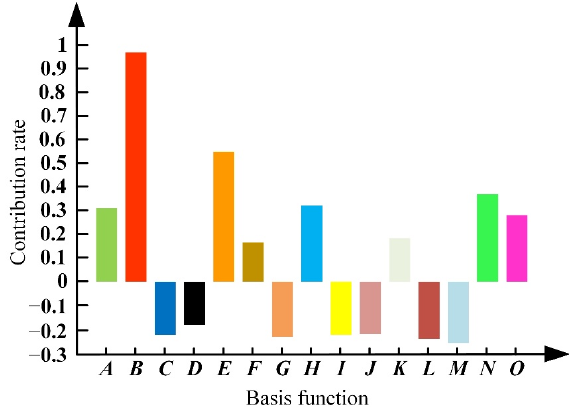
Figure 6. The contribution rate of basis functions.